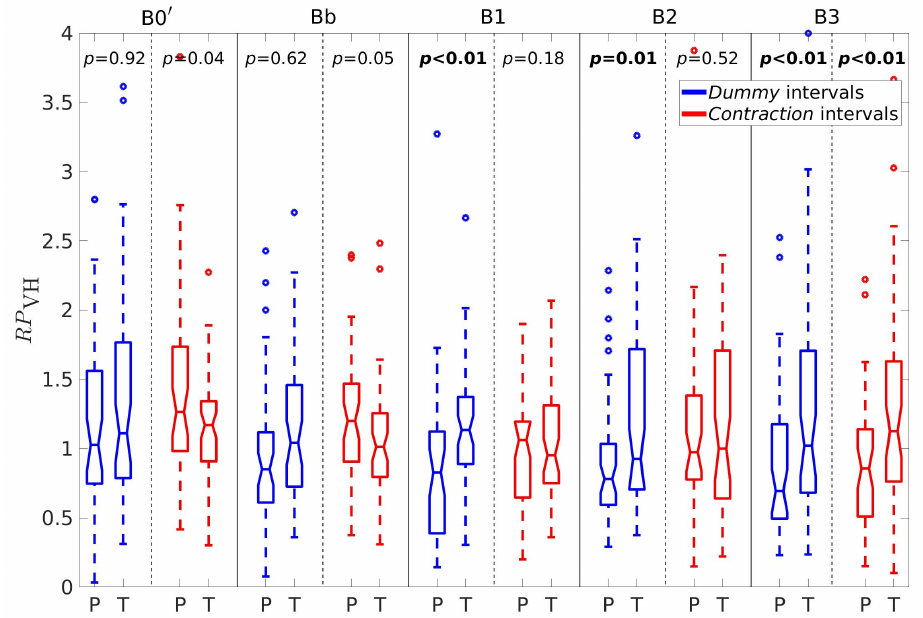
Figure 6. Box plots of the ratio between the percentages of velocity vectors in the vertical and horizontal directions, RP VH . P—preterm intervals, T—term